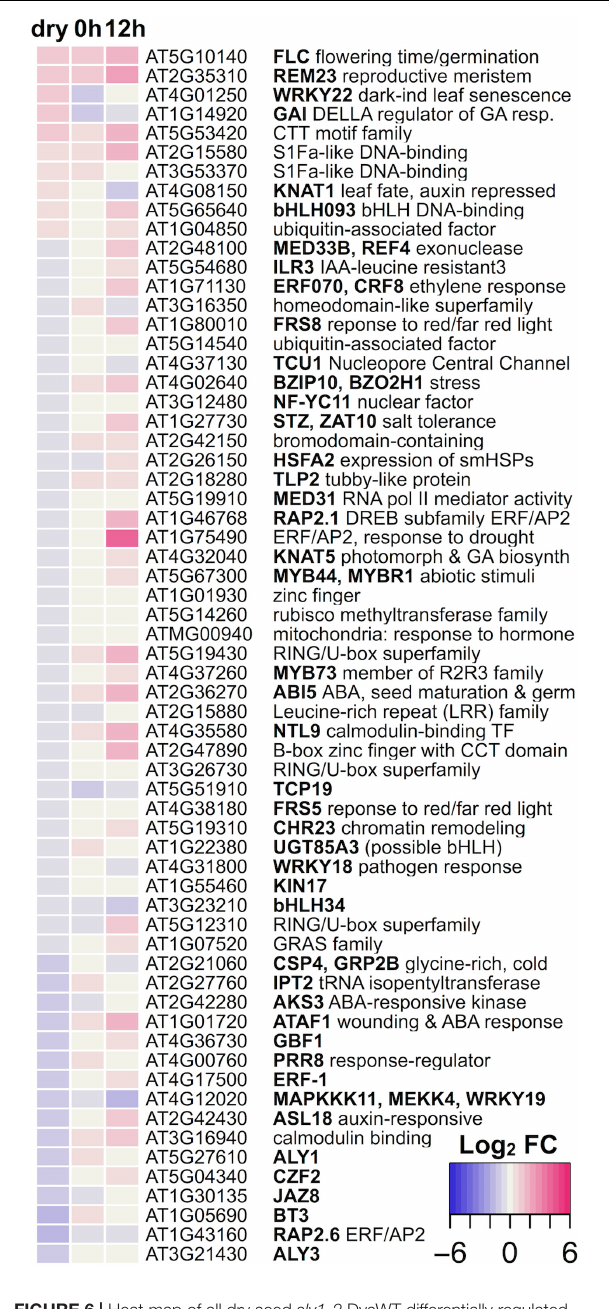
FIGURE 6 | Heat map of all dry seed sly1-2 DvsWT differentially regulated transcription factors showing their expression changes in dry seeds, at 0h, and at 12h of